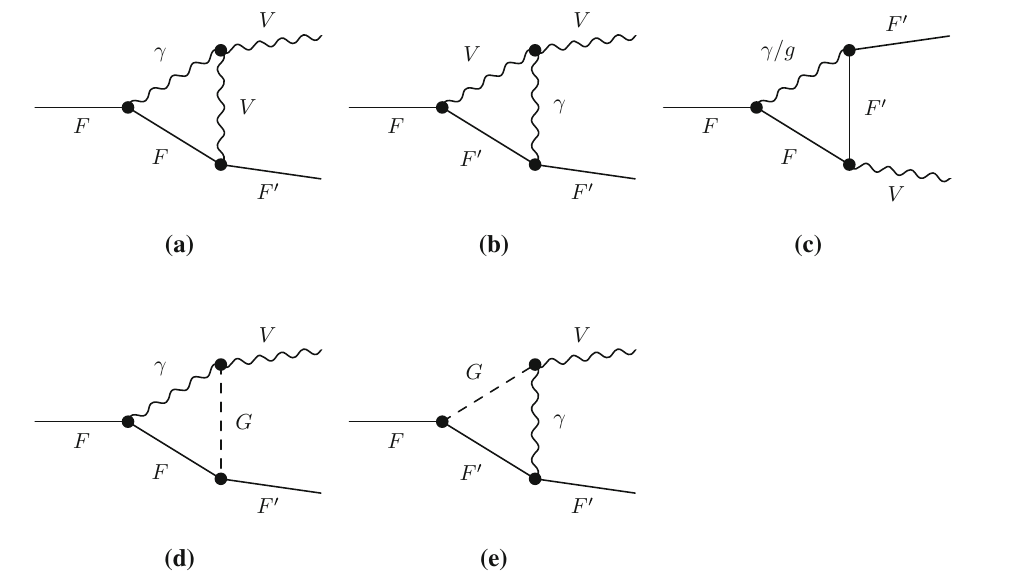
values we must also put the masses of the internal legs to those masses and adjust the couplings accordingly. The same is true of the pair b and